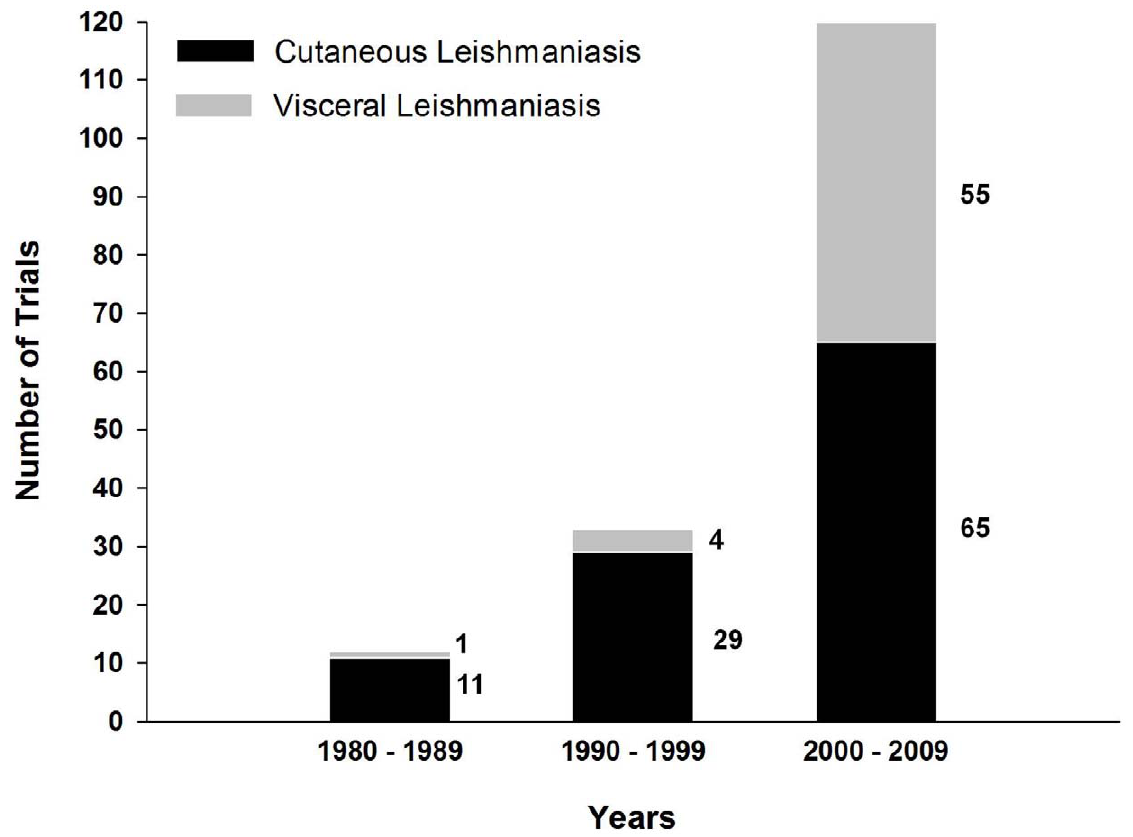
Figure 1. Number of Leishmania vaccine trials in last three decades. Data are derived from Table S1, which contains a summary of all vaccines to date (both experimental and in clinical use). Black bars represent CL: L. major , L. mexicana , L. tropica , L. amazonensis , and L. braziliensis ; gray bars represent VL: L. donovani , L. chagasi , and L. infantum .